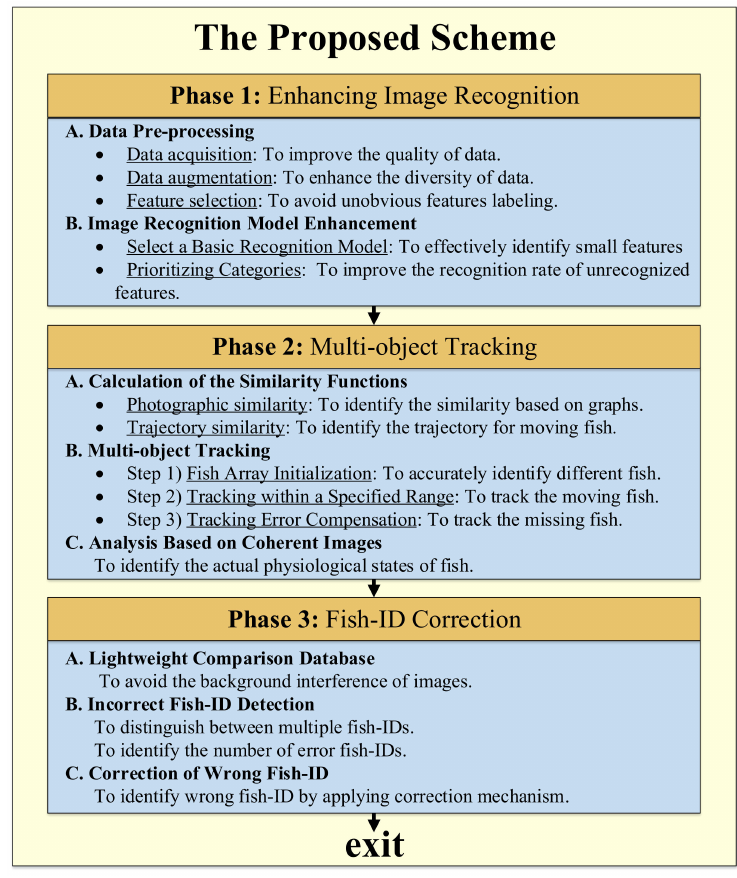
Figure 3. The concept of the proposed